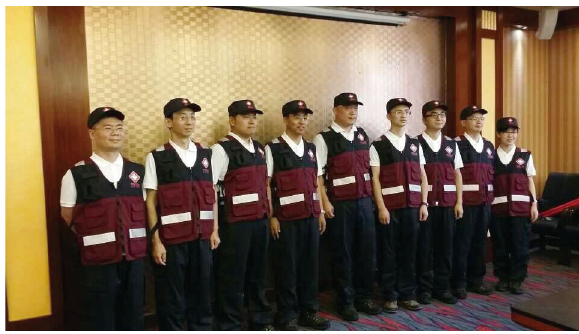
Figure 2. Jun Liu (third from right) and other members of the CDC-teams that went to Africa to help combat the Ebola outbreak in